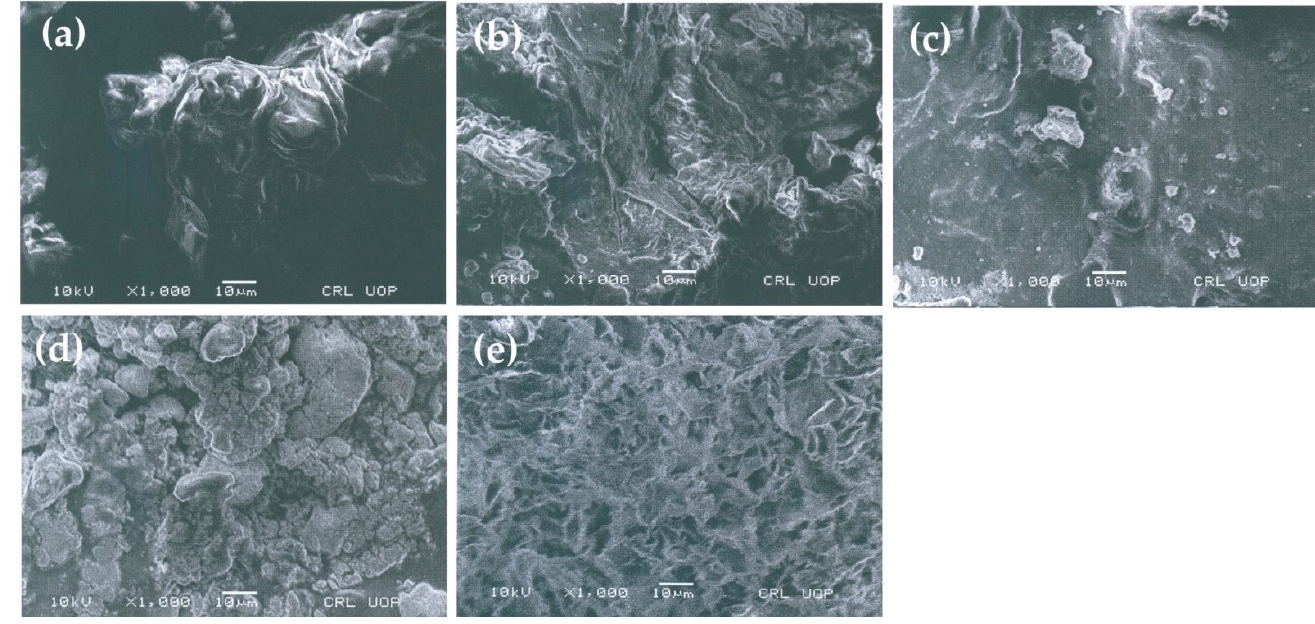
Figure 1. Scanning electron microscope of guar gum: ( a ) Crude guar gum (CGG); ( b ) Purified guar gum (PGG); ( c ) Acid hydrolyzed guar gum (AHGG); ( d ) Basic hydrolyzed guar gum (BHGG); ( e ) Enzymatic hydrolyzed guar gum (EHGG).